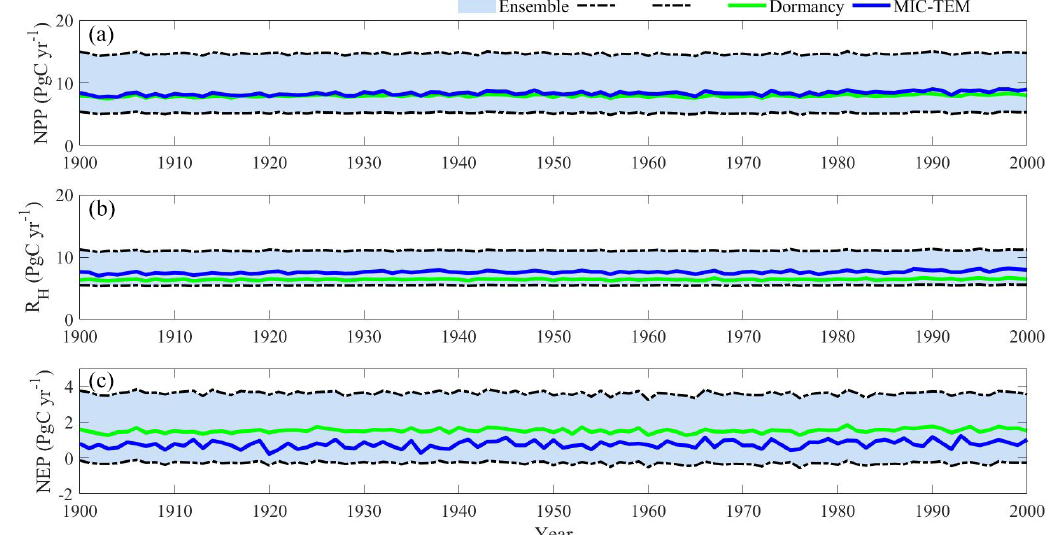
Figure 11. Simulated annual net primary production (NPP, a ), heterotrophic respiration ( R H , b ), and net ecosystem production (NEP, c ) by MIC-TEM-dormancy with an ensemble of parameters.